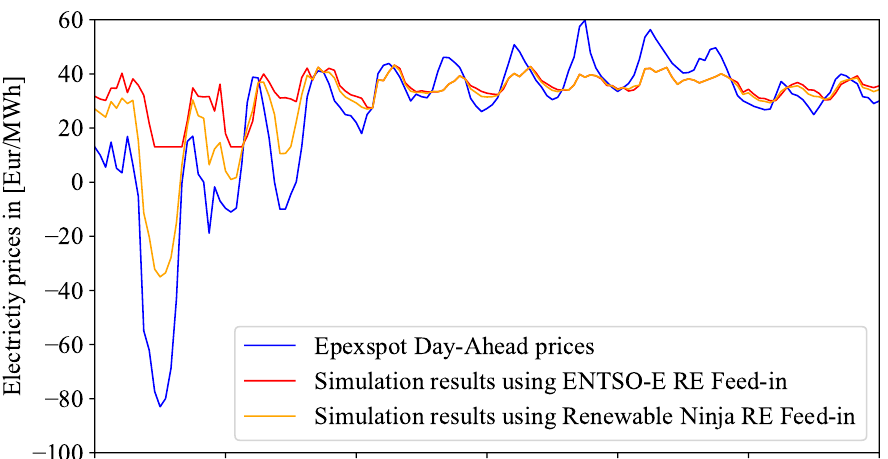
Figure 7. Comparison of day-ahead EPEX SPOT prices and model results for 32 week of 2019 using both ENTSO-E and renewable.ninja